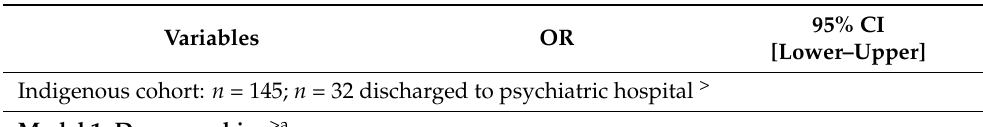
Table 4. Exploratory Logistic Regression Models for Discharge to Psychiatric Hospital for Indigenous